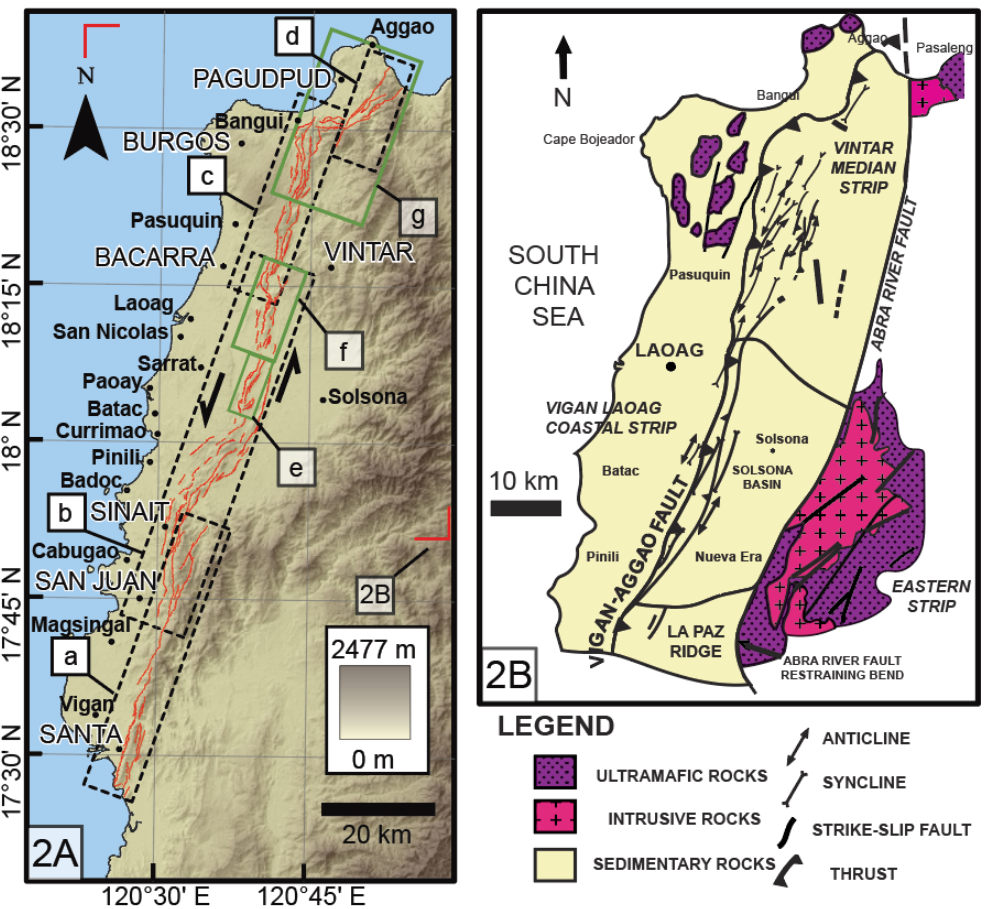
Figure 2. ( A ). Map showing a trace of the Vigan-Aggao Fault (red line), its segmentation (black dashed- line boxes; see Results and Analysis below for the segmentation criteria used), and several featured fault steps/bends (green boxes). a—Santa-Sinait segment, b—San Juan-Vintar segment, c—Bacarra-Burgos segment, d—Pagudpud segment, e—Batac-Laoag bend, f—Sarrat-Vintar-Bacarra bend, and g—Bangui-Pagudpud bend. Location indicated by the black rectangle in Figure 1B. Place names in all caps indicate the bases of fault segment names. B . The known geology and previously assumed structure in the vicinity of the Vigan-Aggao Fault (location indicated by red corners in Figure 2A). Directly east of the Vigan-Aggao Fault is another splay of the PFZ—the Abra River Fault. To the west of the Vigan-Aggao Fault is the Vigan-Laoag Coastal Strip, which is characterized by a metamorphosed Cretaceous ultramafic basement that is uncorformably overlain by a thin Eocene to Miocene sedimentary cover. To its north are Oligocene to Early Miocene granitic bodies, which intrude the metamorphic rocks. To the east of the fault is a thick sequence of predominantly clastic sedimentary units that are as old as Late Eocene (modified after Pinet and Stephan, 1990 [8]).